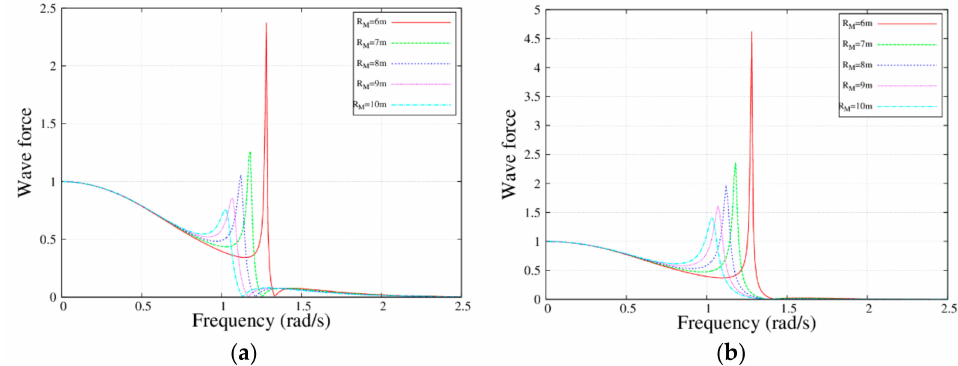
Figure 3. Wave load with the frequency for the MP and the WEB with di ff erent radius; R M = 6, 7, 8, 9 E = 6 m; and ( b ) F E = 6 m. and 10 m. ( a ) F M , d M B , d M